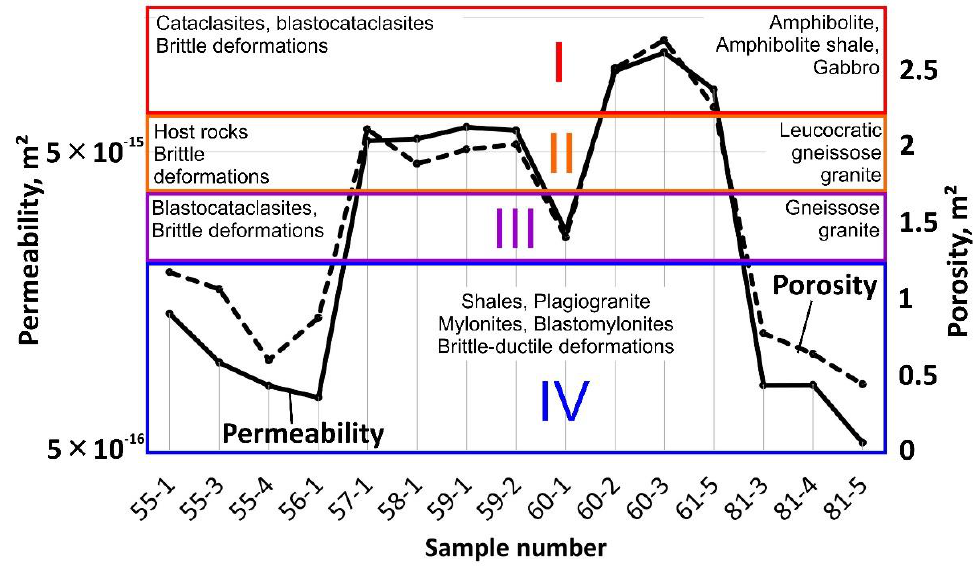
Figure 10. Integration of the data of petrographic and microstructural analyses of rock samples collected across the Primorsky Fault.